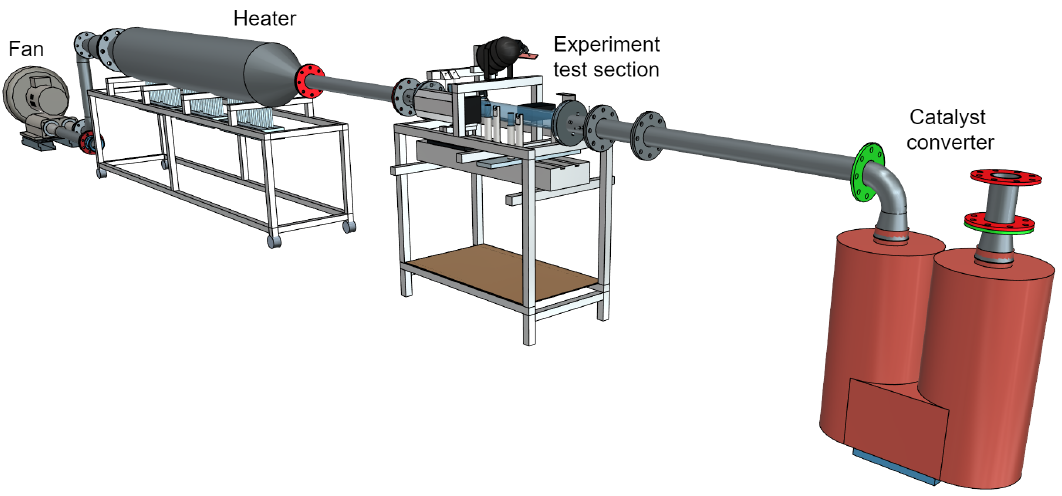
Figure 7. Hot gas test bench enabling various SCR investigations such as depositions, injector mapping, thermology, as well as ammonia concentration distribution measurements using different pipe